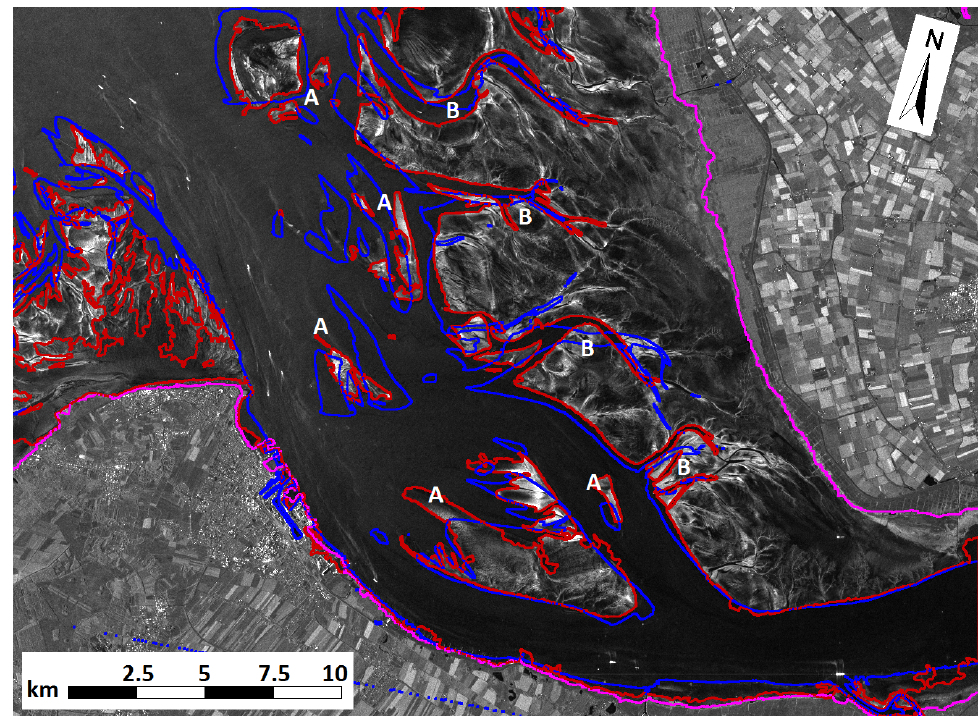
Figure 2: Sub-scene of a TerraSAR-X SM scene of the Elbe estuary, acquisition parameters are given in Table 1. The red lines indicate the boundaries found by our algorithm, the blue lines indicate the Lowest Astronomical Tide (LAT) level according to the bathymetry data and the magenta lines show the SWBD coastline. The letters indicate selected differences to the bathymetry data for shifted sand banks (A) and tidal inlets